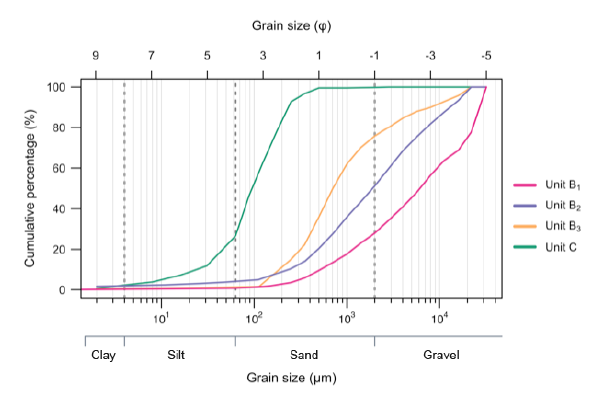
Figure A1. Grain-size distribution curves of the sedimentary units (two samples per subunit). The gravel fraction was removed prior to